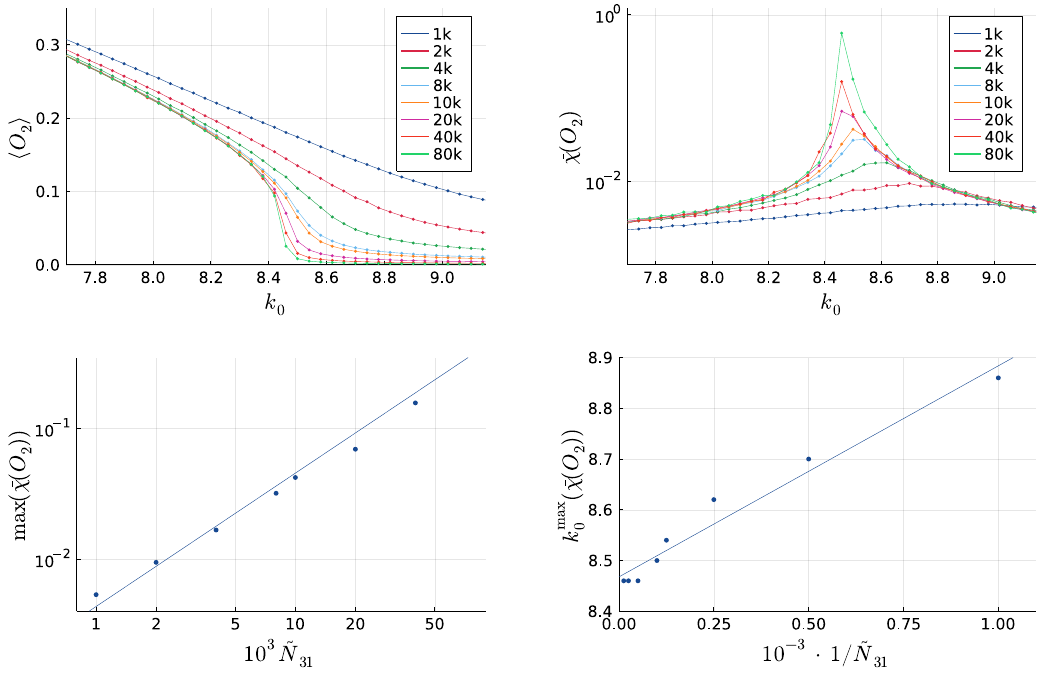
Figure 5. Top left: the expectation value of the order parameter h O 2 i as a function of k 0 for nine distinct system volumes with spatial genus g = 1 . Top right: the susceptibility ¯ χ ( O 2 ) as a function of k 0 . Bottom left: the height of the peaks of the normalized susceptibility as a function of the target system volume ˜ N 31 . Bottom right: the location of the peaks of the susceptibility as a function of the inverse target system volume 1 / ˜ N 31 . Error bars for the plots in the top row are smaller than dot size, except near the peaks of the susceptibility, where they are also omitted for